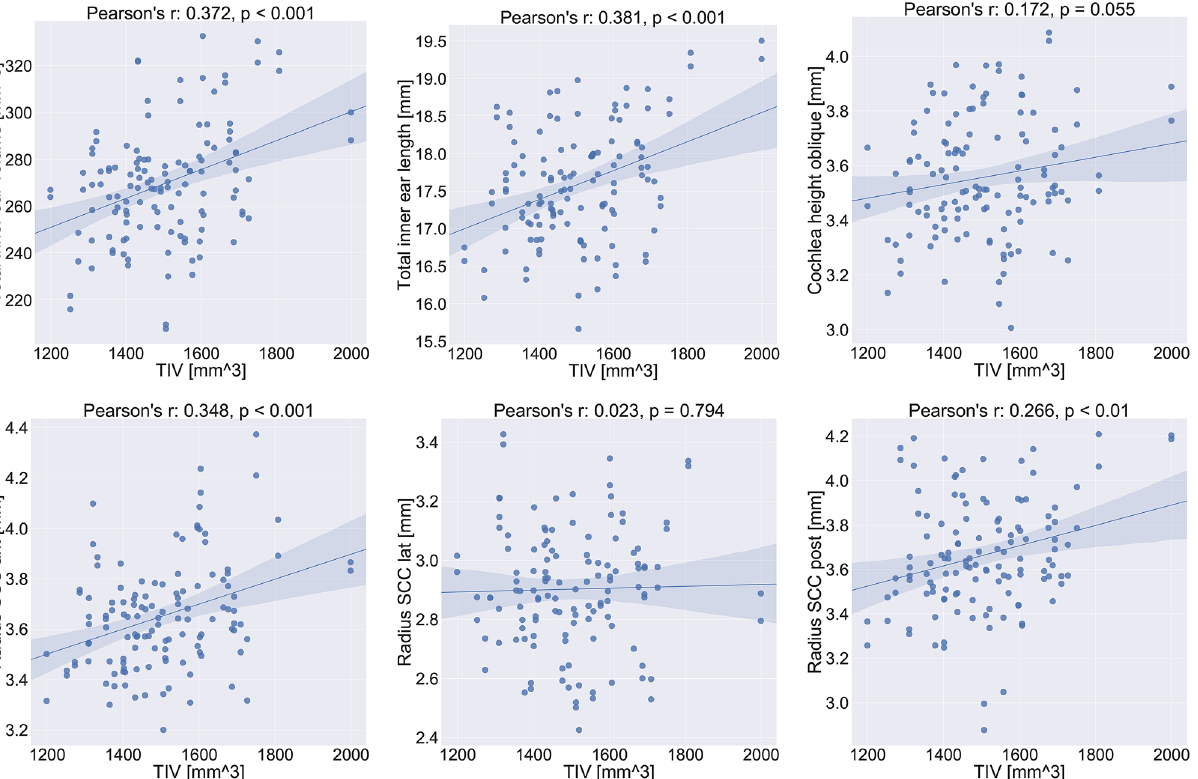
Figure 3. Correlation plots for inner ear measurements with total intracranial volume (TIV). Linear correlation values (Pearson’s r) and corresponding p -values are indicated in the subplot titles. The 95% confidence interval for the regression estimate is drawn as a translucent band around the regression line. Total inner ear volume and length, as well as the radii of the anterior and posterior semicircular canals (SCC) are linearly correlated with head size. The oblique cochlea height might well be while the radius of the lateral SCC appears to not be correlated at all with TIV. The results indicate the importance of TIV for future quantitative assessments between cohorts. (Figure panels created with seaborn v0.11.0 https ://seabo rn.pydat